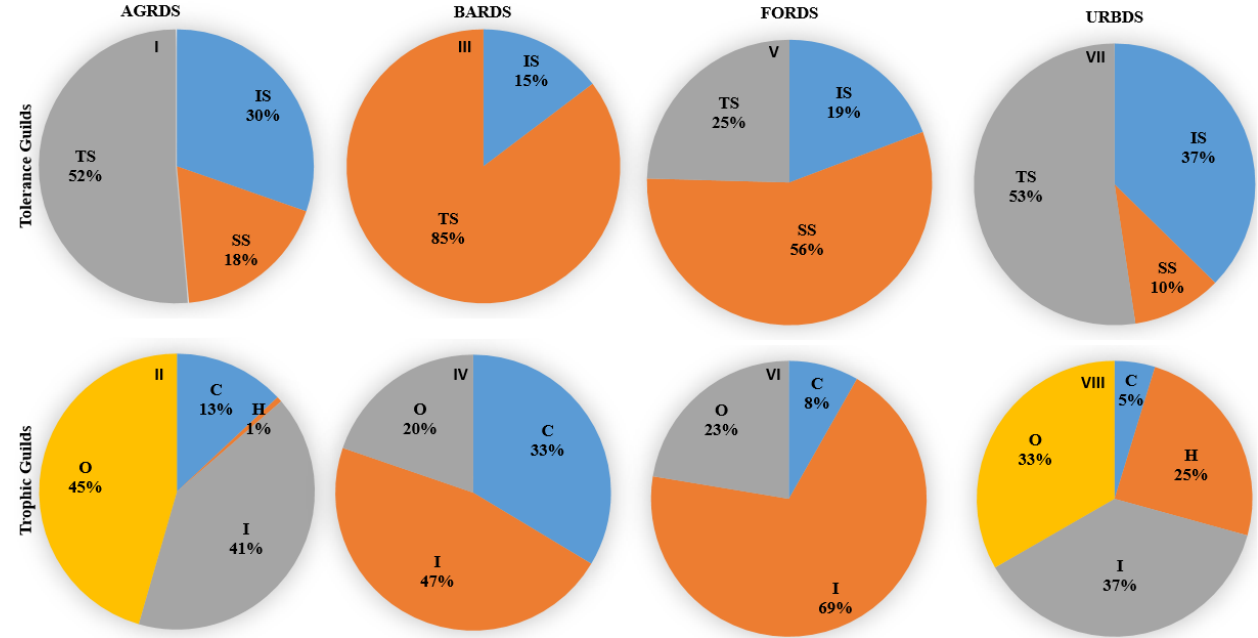
Figure 6. Trophic and tolerance guild variations at different land cover-dominated sites in the Nakdong River basin. SS: sensitive species, IS: intermediate species, TS: tolerant species, O: omnivores, I: insectivores, C: carnivores, and H: herbivores. (AGRDS: agricultural coverage-dominated sites — ( I , II ), BARDS: barren coverage-dominated sites — ( III , IV ), FORDS: forest coverage-dominated sites ( V , VI ), URBDS: urban coverage-dominated sites — ( VII , VIII ). Table 3. Fish fauna and guild composition in the Nakdong River watershed. (Tol. G.: tolerance guild, Tro. G.: trophic guild, Hab. G.: habitat guild, AGRDS: agricultural coverage-dominated sites, BARDS: barren coverage-dominated sites, FORDS: forest coverage-dominated sites, URBDS: urban coverage-dominated sites, TNI: total number of individuals, TRA: total relative abundance, TNS: total number of species, ¥: exotic species, EDS: ecologically disturbing species, *: endangered species, SS: sensitive species, IS: intermediate species, TS: tolerant species, O: omnivores, I: insectivores, C: carnivores, H: herbivores, RB: riffle benthic